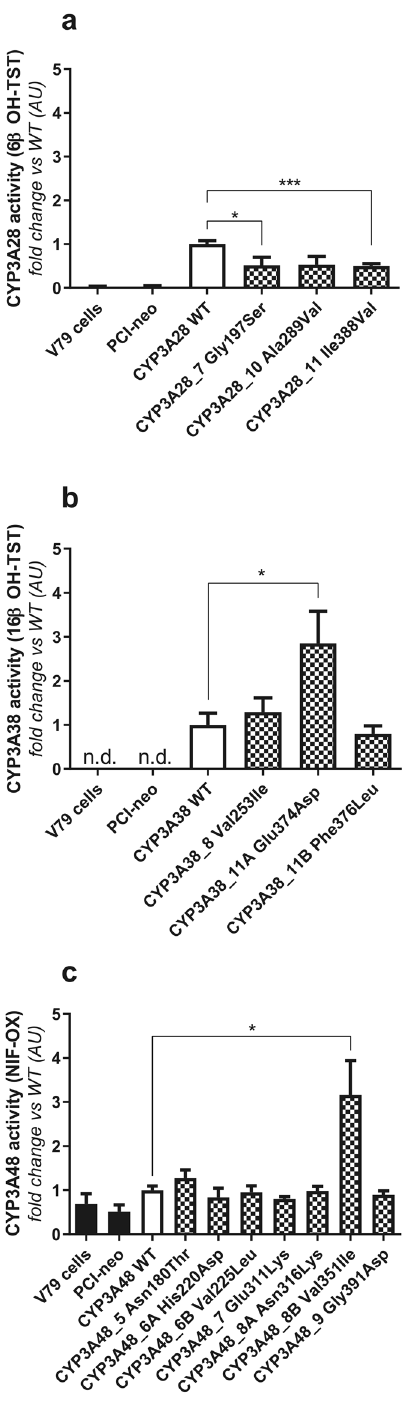
Figure 1. Catalytic activity of V79 cells expressing wild-type and mutant ( a ) CYP3A28, ( b ) CYP3A38 and ( c ) CYP3A48. After incubation of transfected V79 cells with 25 µ M TST or 5 µ M NIF for 3 or 1.5 hours, the medium was subjected to LC-MS/MS analysis as reported in the Material and Methods. The catalytic activity of wild- type and mutant CYP3A28, CYP3A38 and CYP3A48 proteins was calculated dividing the amount of metabolite formed by the incubation time and the total protein content (nmoles min − 1 mg − 1 protein). Variant CYP3A specific activities were normalized to that of the wild-type CYP3A isoform (set at 1.00). Four independent experiments were performed. Unpaired T-test was used for statistical analysis ( * p < 0.05; *** p < 0.001). AU: Arbitrary